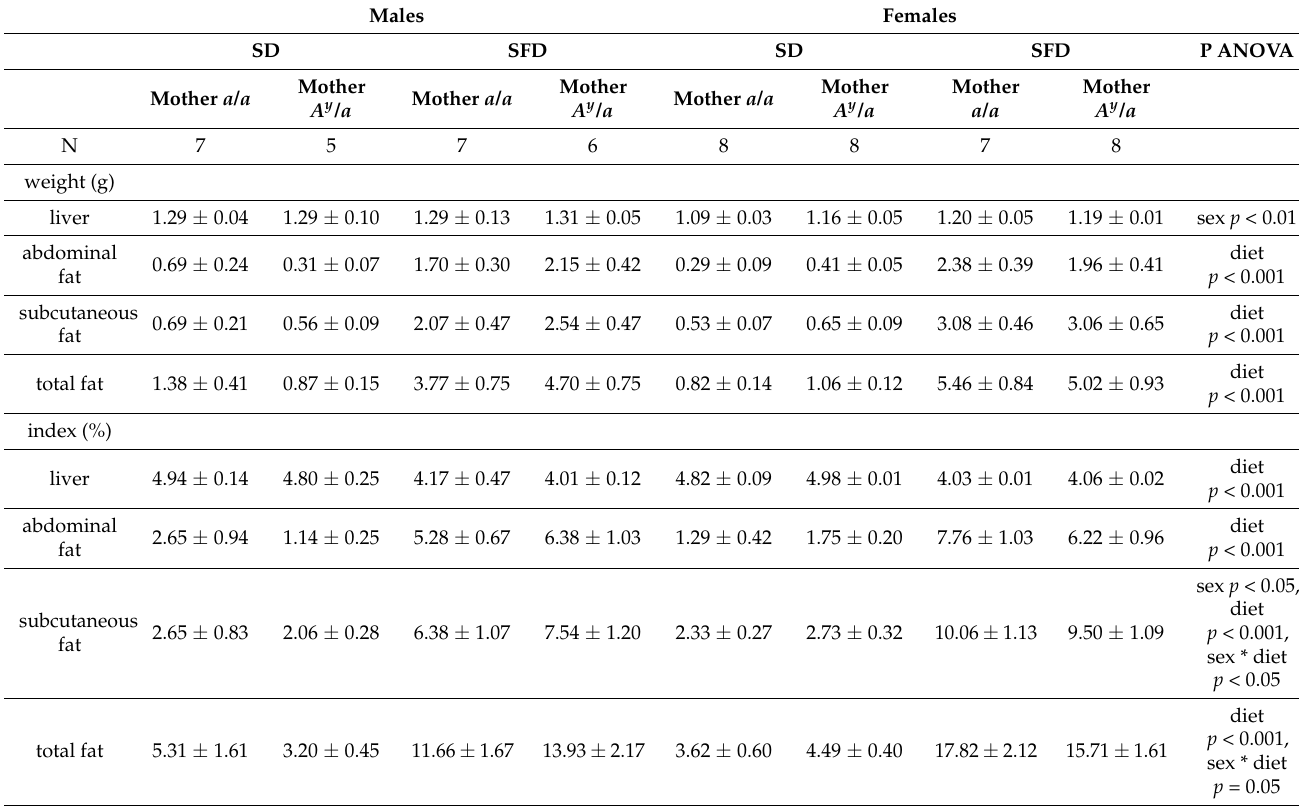
fat did not depend on sex, but the accumulation of subcutaneous fat was higher in females (Table 2). Maternal obesity had no effect on fat masses and liver weight in the offspring. SFD consumption and obesity development were accompanied by increases in the plasma concentrations of glucose, insulin, and FGF21 in mice of both sexes, regardless of maternal obesity (Table 3). Separate analyses for males and females showed that only in females, regardless of maternal genotype, SFD intake increased liver glycogen stores ( p < 0.01, two-way ANOVA, diet, MG). The effect of maternal obesity on blood biochemical parameters was found only in males. SFD consumption was accompanied by an increase in cholesterol plasma levels only in males born to obese mothers (two-way ANOVA, diet, MG, p < 0.01 N-K). In addition, males born to obese mothers had higher levels of blood glucose than male offspring of control mothers when consuming the SFD (two-way ANOVA, diet, MG, p < 0.01 N-K). Table 2. Weight characteristics in male and female offspring of control and obese mothers on a standard diet and sweet and fatty diet. Males Females SFD SD SFD P ANOVA